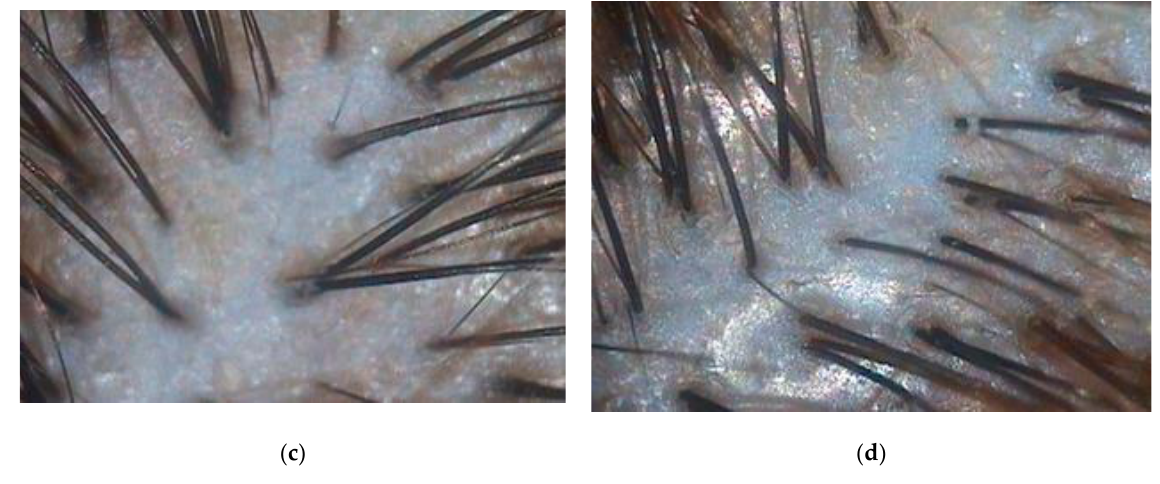
Figure A1. Microphotographs of hair density before and after the trial in the patient K-va of the experimental Group 1. ( a ) Hair density on the frontal area before the trial; ( b ) hair density on the frontal area after the trial; ( c ) hair density on the occipital area before the trial; ( d ) hair density on the occipital area after the trial.